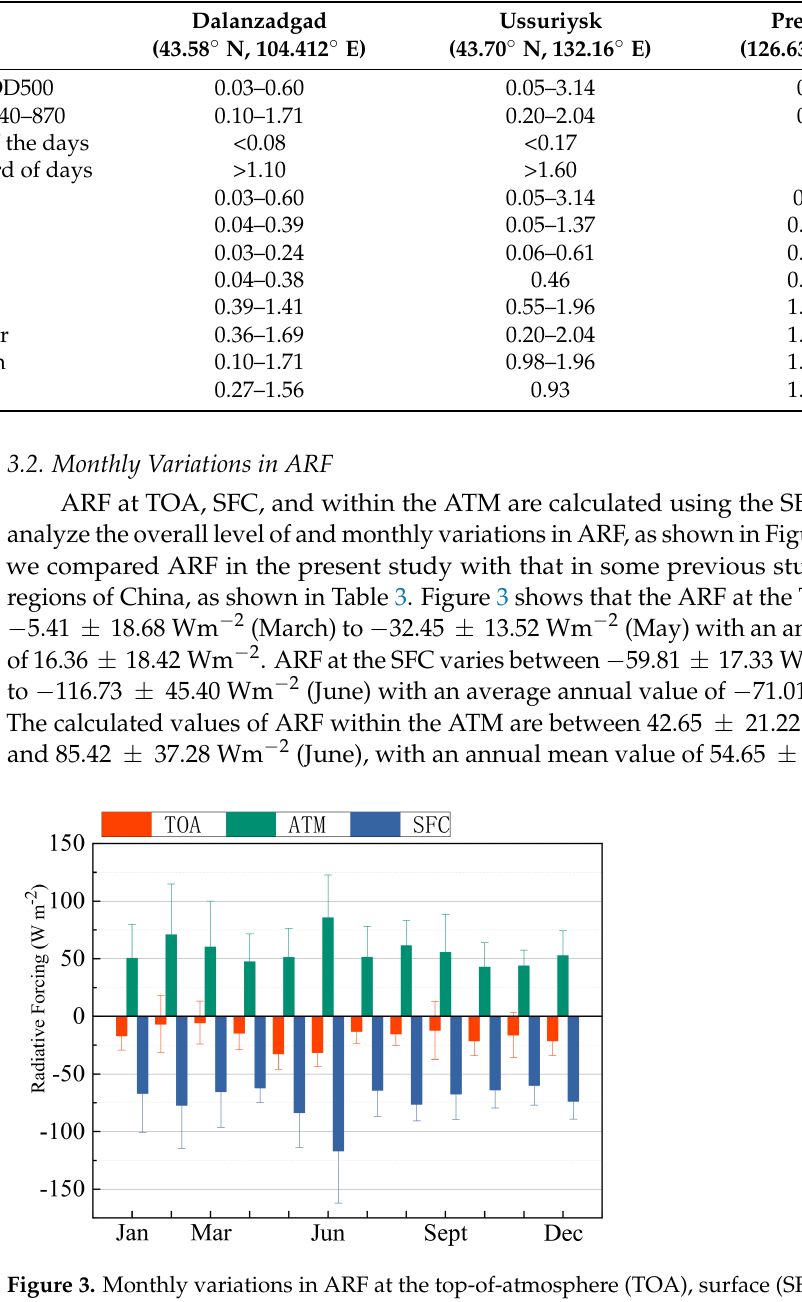
Table 2. Comparison of AOD500 and AE440–870 measurement results at Harbin and nearby AERONET sites.